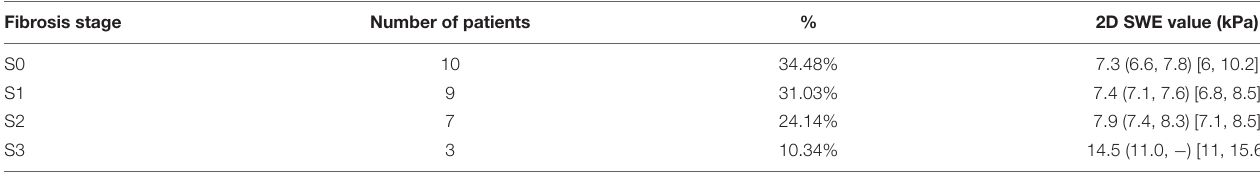
TABLE 2 | Two-dimensional shear wave elastography (2D-SWE) values in the pediatric patients with normal serum ALT level (ALT (cid:53) 1ULN) after liver transplantation (LT) according to liver fibrosis stage. Fibrosis stage